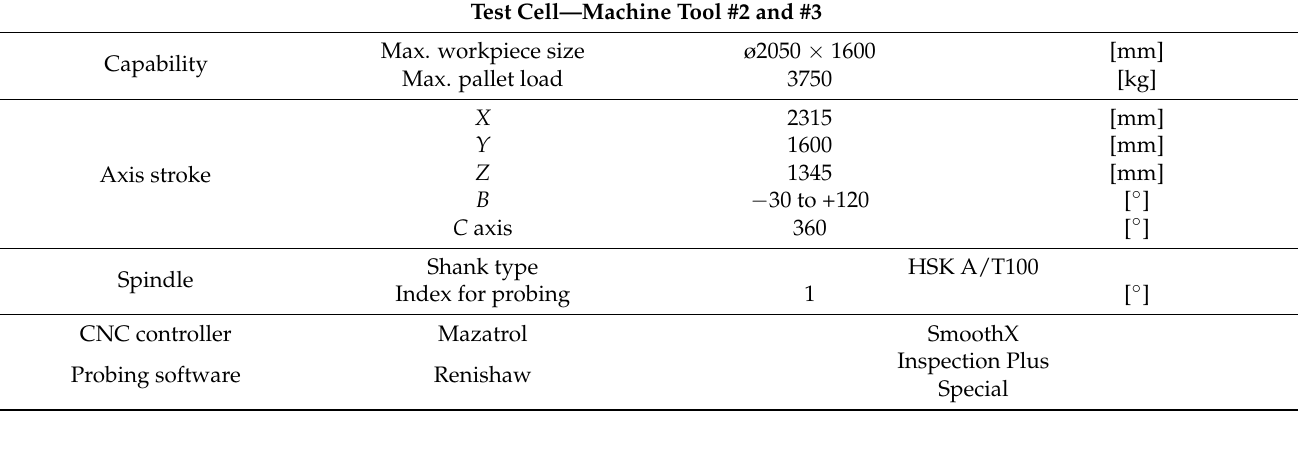
Table 1. General scope of the 5-axis multitasking machine tool used in our study—MT specifica- tion outline.